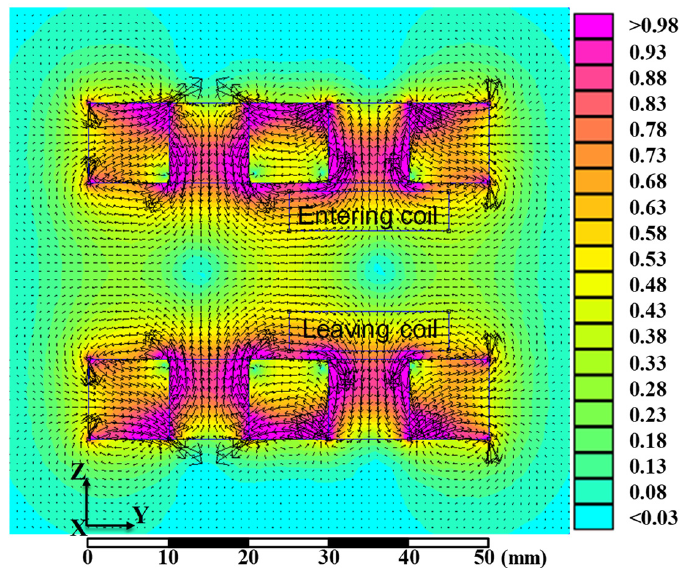
Figure 5. Magnetic flux density (Tesla) around the linear Halbach arrays.